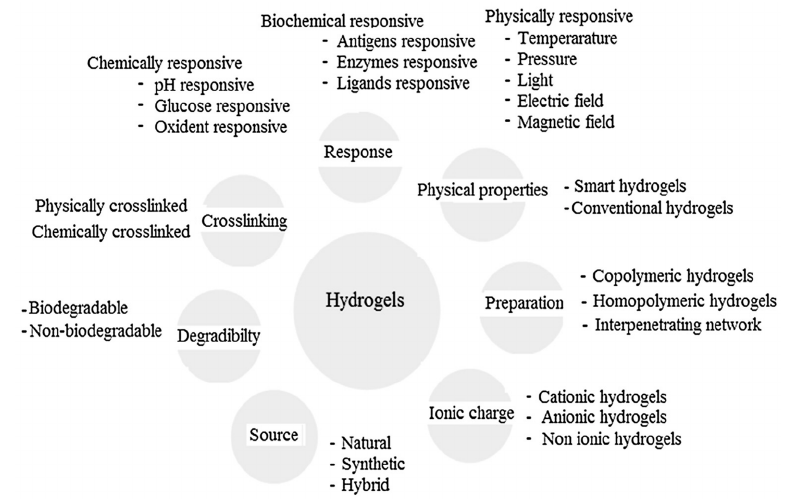
Figure 5. Classification of hydrogels based on the different properties. Reproduced with permission from [13].